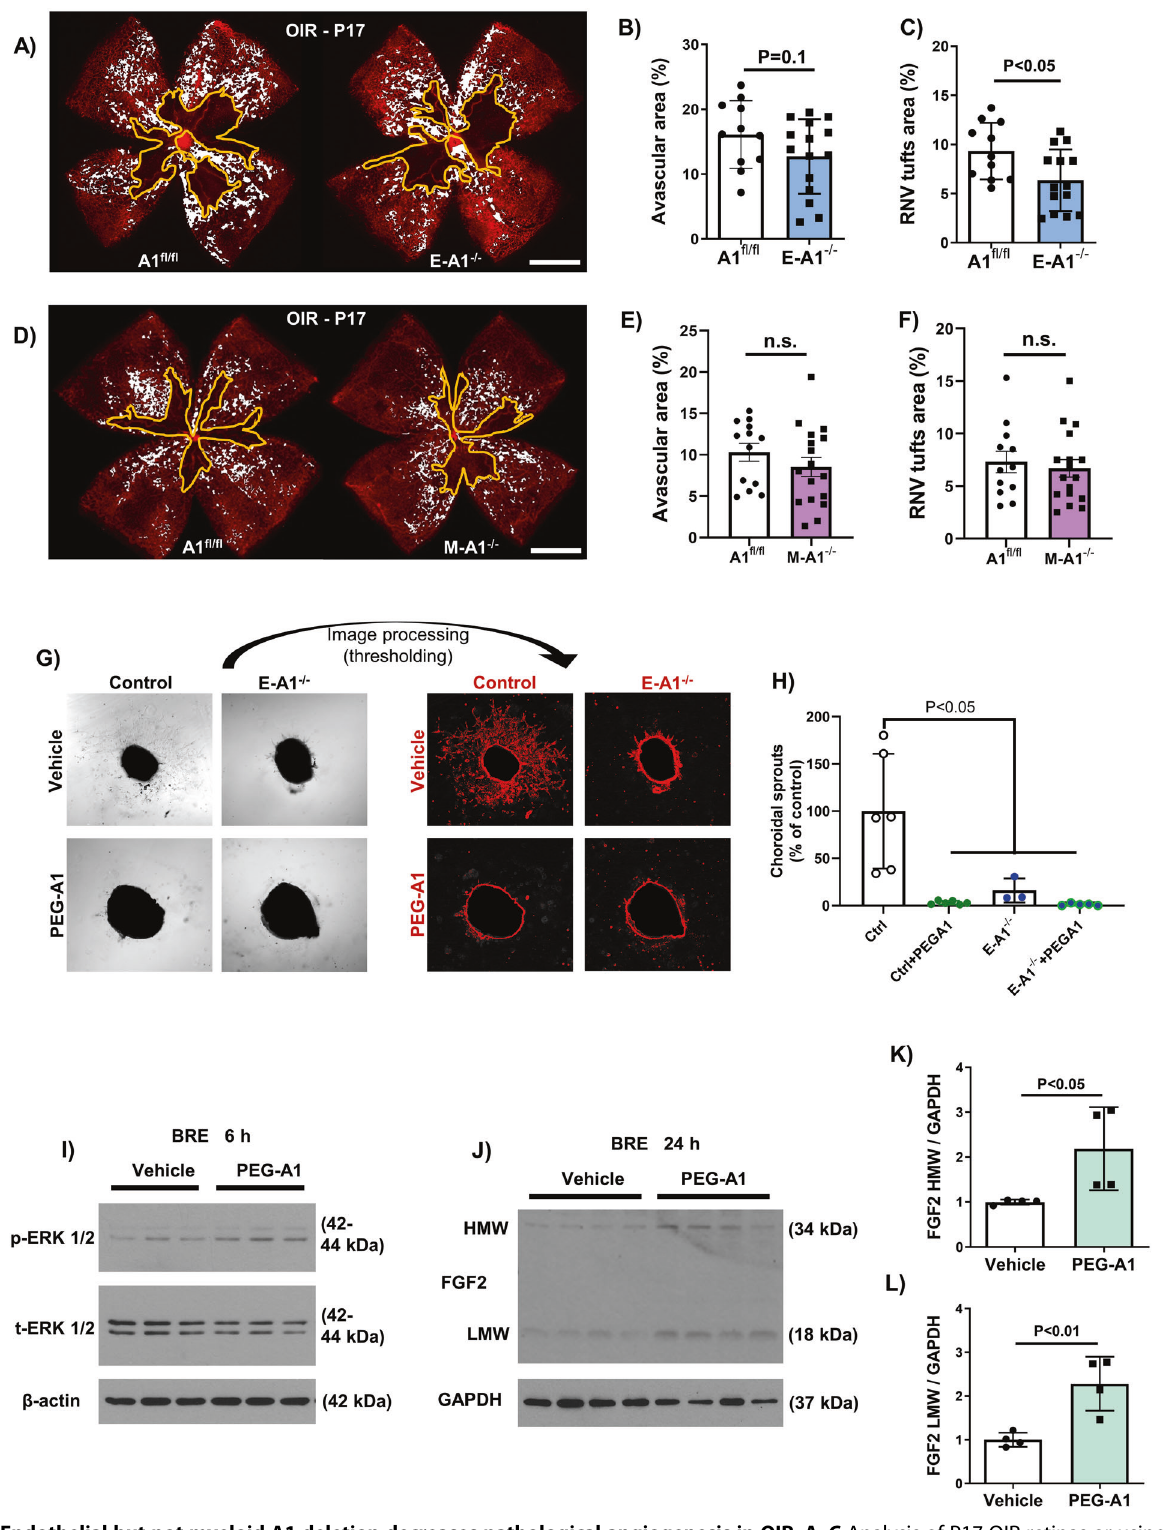
Fig. 7 Endothelial but not myeloid A1 deletion decreases pathological angiogenesis in OIR. A – C Analysis of P17 OIR retinas or using lectin staining showed a signi fi cant decrease in pathological neovascularization (NV, highlighted in white) in endothelial A1 knockout mice (E-A1 − / − ) as compared to littermate fl oxed controls (A1 f/f ), while the AVA (yellow outline) showed a decreasing trend that was not statistically signi fi cant. Scale bar = 100 µm. D – F Analysis of myeloid A1 knockout mice (M-A1 − / − ) OIR retinas showed no change in AVA or NV tuft formation at P17 as compared to littermate fl oxed controls (A1 f/f ). Scale bar = 100 µm. G , H Choroidal angiogenesis assay and quanti fi cation showed marked suppression of the angiogenic response with endothelial A1 deletion or PEG-A1 treatment. I – L Treatment of bovine retinal endothelial cells with PEG-A1 for 6 h led to increased ERK phosphorylation as measured by western blotting while 24 h treatment increased FGF2 protein levels. Cell Death and Disease (2022)